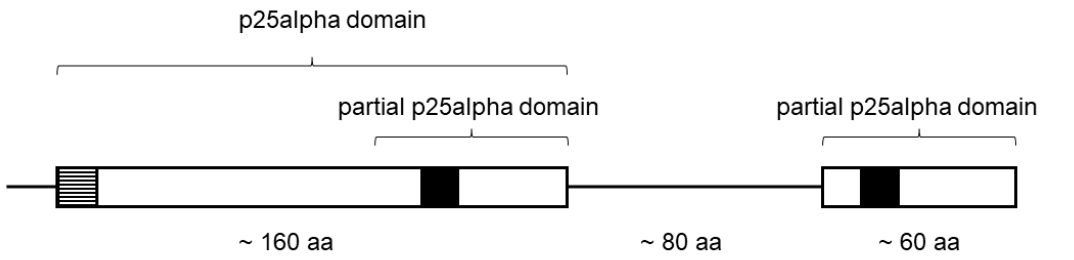
Figure 1. Schematic structure of a fungal-type TPPP. The positions of the Rossmann-like motifs (GXGXGXXGR) are indicated by black squares. The dashed line square indicates the LxxxF(Y)xxFxxF sequence. aa- amino acids.